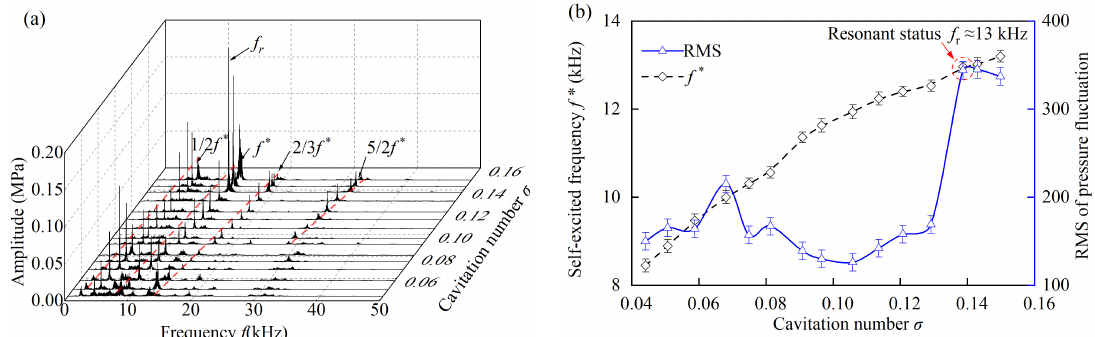
Figure 4. Different oscillation statuses of the self-excited waterjet. ( a ) Waterfall spectra of pressure fluctuation as a function of cavitation number; ( b ) frequency and pressure fluctuation RMSs as a function of cavitation